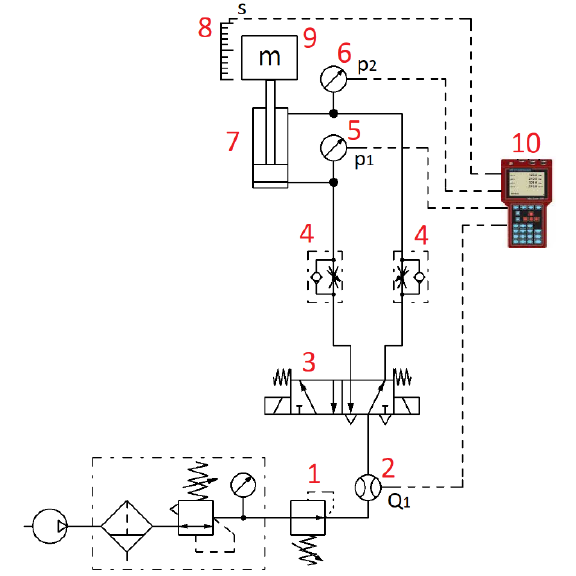
Fig. 4. Scheme of pneumatic circuit for reference